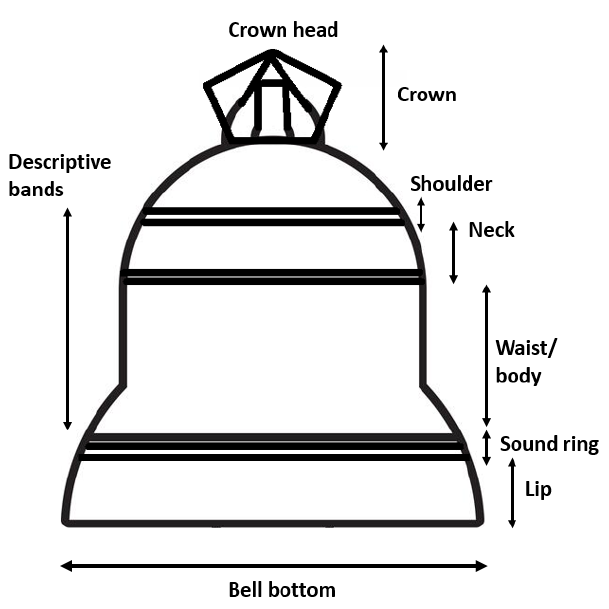
Figure 1. Schematic description of the bell structure.